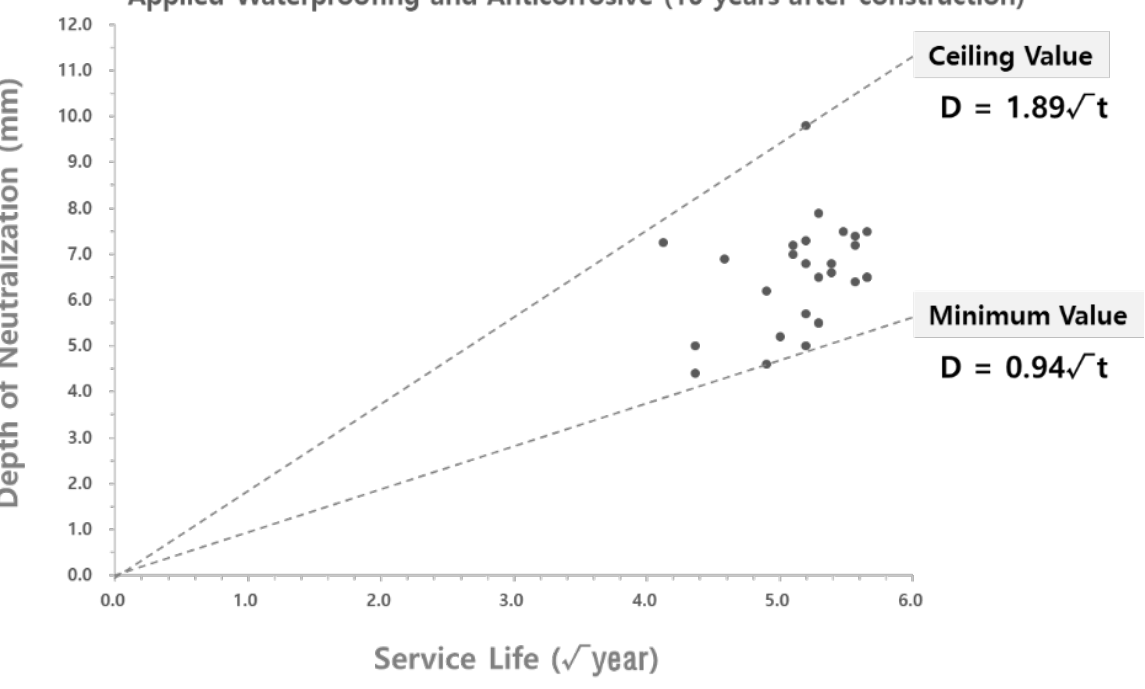
Figure 7. Carbonation depth distribution on the inner wall of the water reservoirs (waterproof- ing/anticorrosive method applied after 10 years of service life) - reflect on-site adjustments